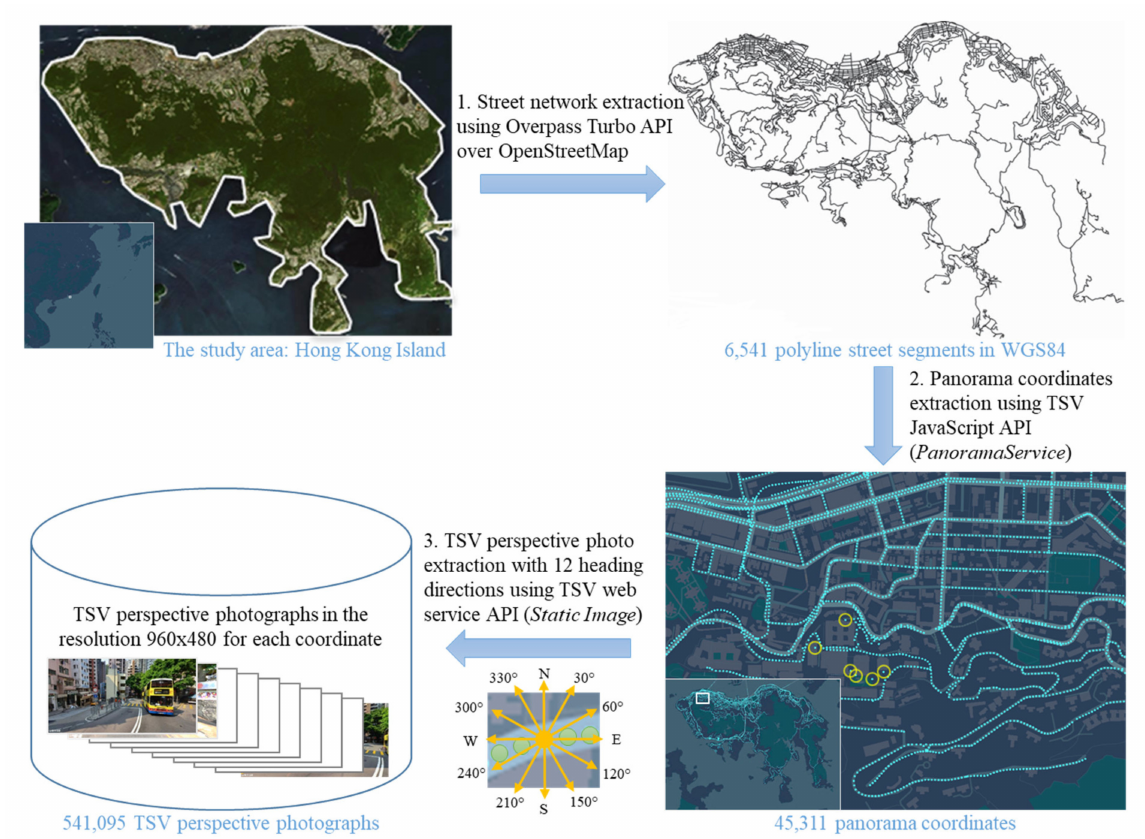
Figure 3. Data collection process: (1) generate street network from OpenStreetMap; (2) extract coordinates of TSV panorama photos; (3) segment panorama photos into TSV perspective